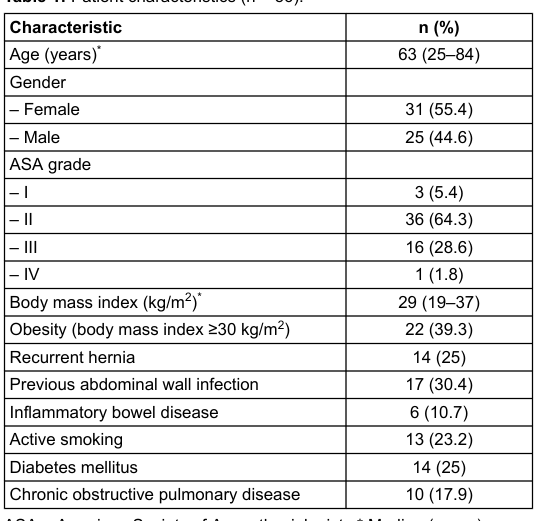
Table 1: Patient characteristics (n = 56).